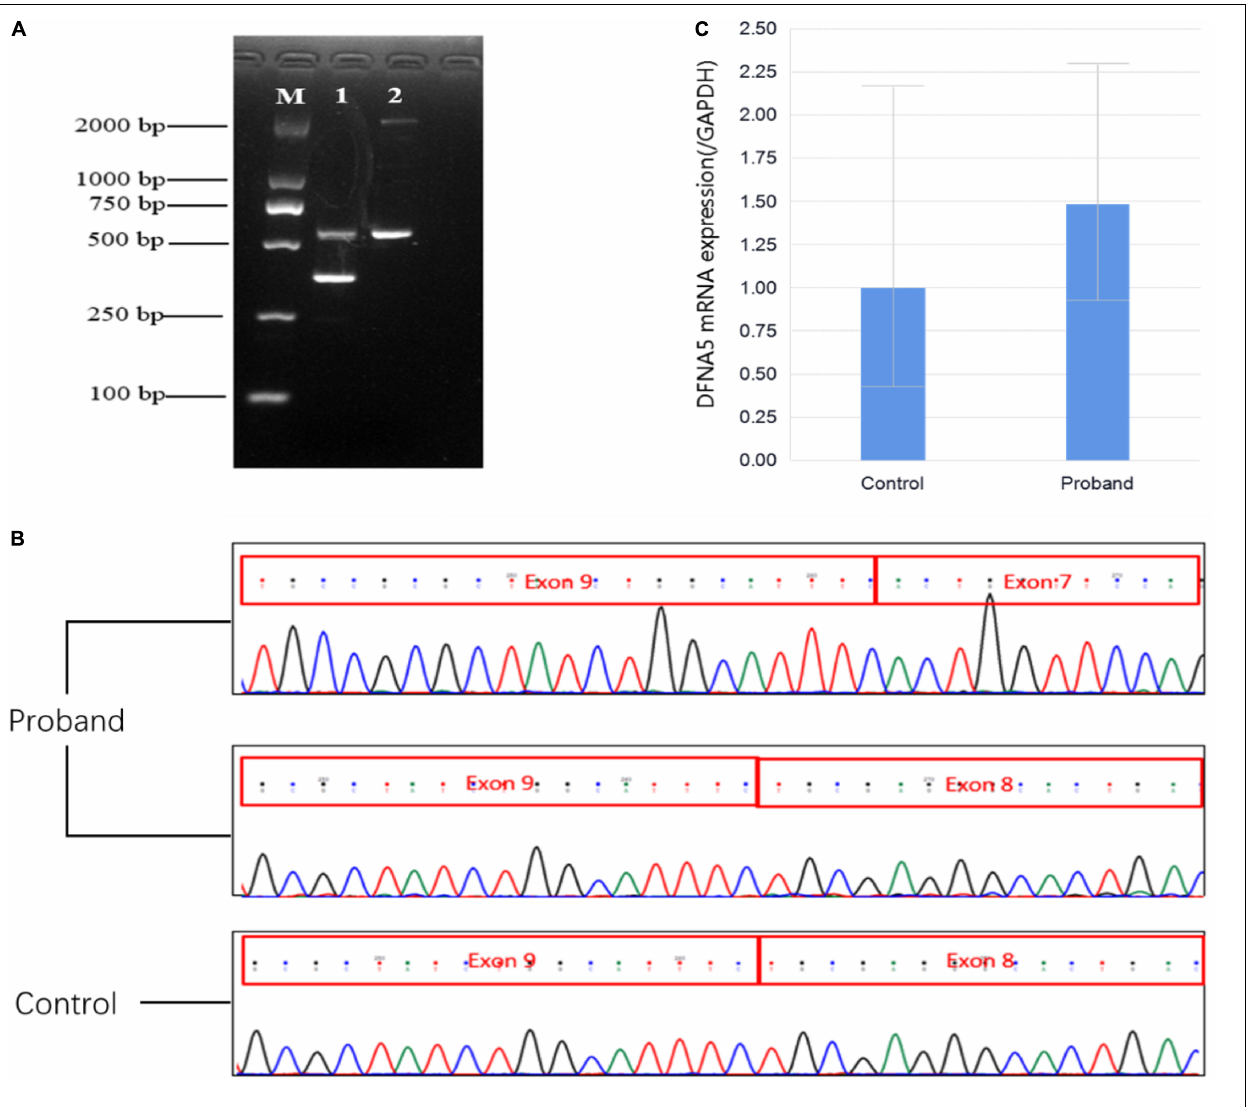
FIGURE 2 | (A) Agarose gel electrophoresis. M: 2,000-bp marker; 1: cDNA product of the proband; 2: cDNA product of the control. (B) Sanger sequencing chromatograms of the cDNA products. The proband sample shows a sequence of the 392-bp fragment, indicating the connection of exon 9 and exon 7 and a sequence of the 585-bp fragment, indicating the connection of exon 9 and exon 8; the control sample shows a sequence of the 585-bp fragment, indicating the connection of exon 9 and exon 8. (C) Quantification of the qPCR products of DFNA5 mRNA. The DFNA5 mRNA expression level in the proband was 1.482-fold of that in the